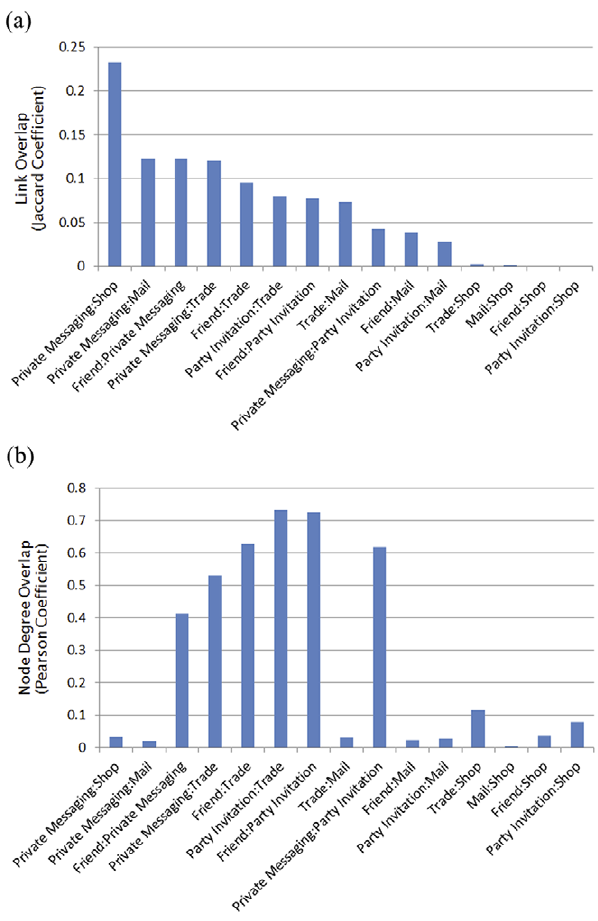
Figure 6. Pairwise network overlaps indicating the similarity or dependence between interactions. (a) The link overlap. The largest link overlap is found between the Private Messaging and the Shop networks, reflecting the fact that private messaging (for bargaining) nearly always precedes the sales of items via the Shop interaction. (b) The node overlap quantifying the node degree overlap between different networks. High degree overlaps occur between the four social- type networks, indicating that many gamers make a fair mix of the actions. The low degree overlaps in different pairs indicate the role specialization discussed in the